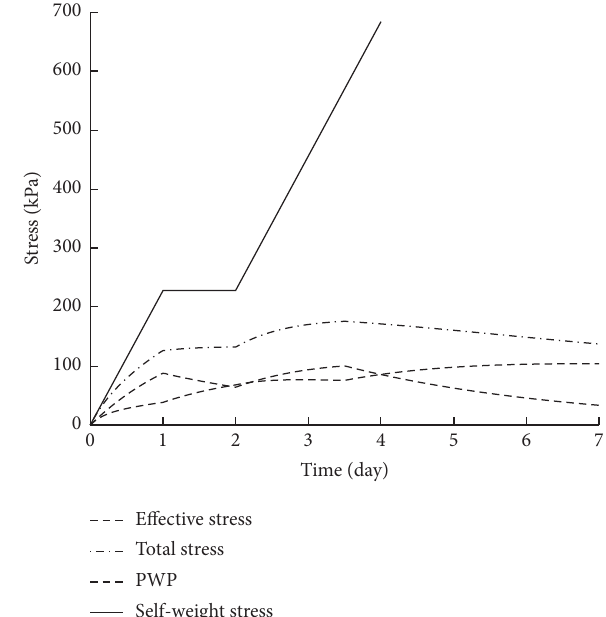
Figure 5: Effect of operation time on the variation of internal stress in CPB.